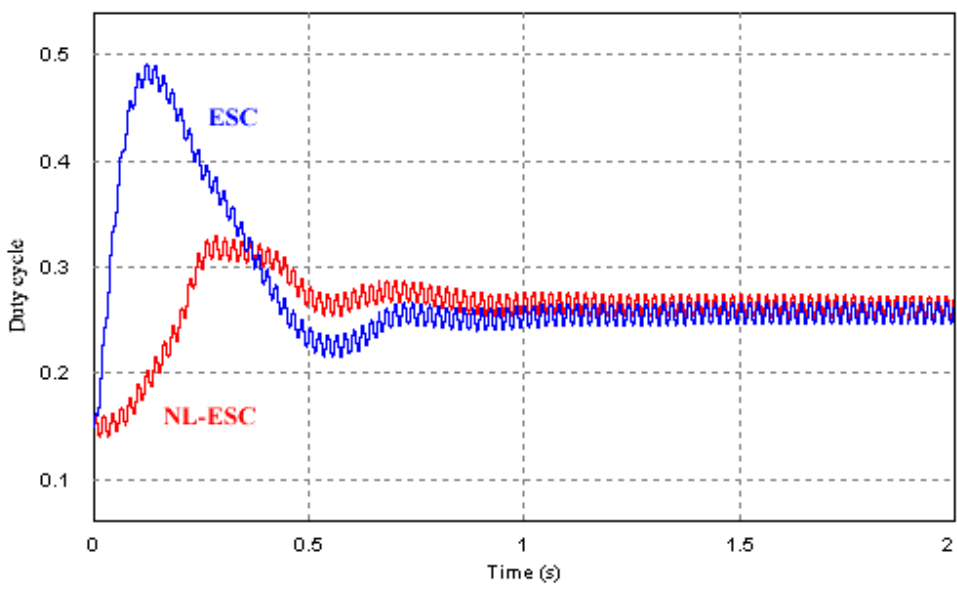
= 0.15 in NL-ESC case ( Red ); i = 0.15 in ESC case ( Blue ). i